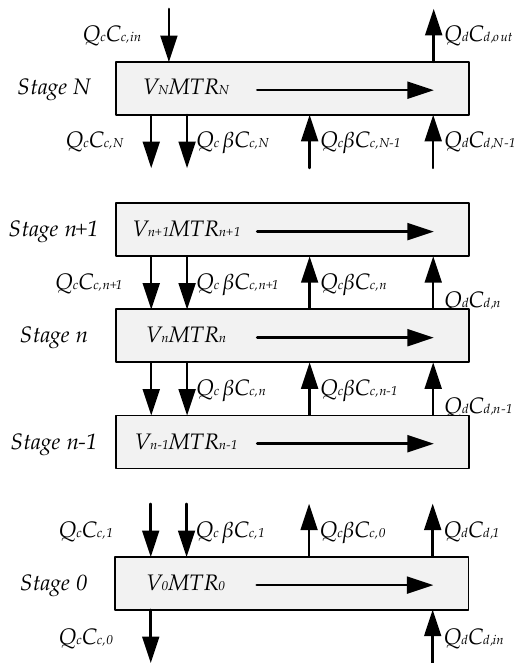
Figure 8. Counter-current extraction model block flow diagram.